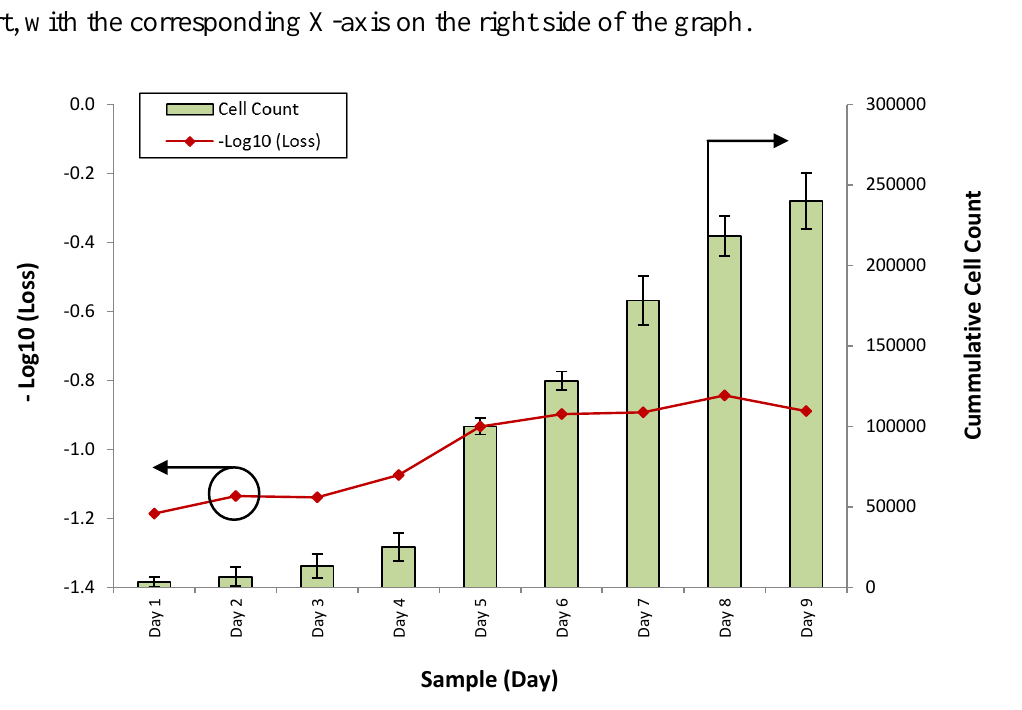
Figure 3. −Log (Power Loss) and cumulative cell count against different conditioned 10 media samples for the WJSC.SC3 cell line. The power loss is represented by the line graph, with the corresponding X-axis on the left, while the cell count is represented by the bar chart, with the corresponding X-axis on the right side of the